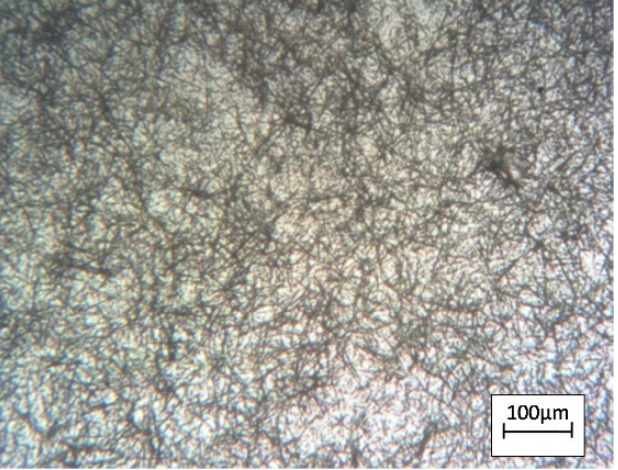
Figure 5. Silver nanowires obtained by adding K 4 Fe(CN) 6 in the field of an optical microscope. The structural characteristics of the silver nanowires synthesized by both conven- tional and microwave methods were studied by scanning electron microscopy (SEM). Figure 6 shows the SEM images of Ag_NW nanowires obtained by the conventional method (Figure 6a) and those obtained by microwave radiation (Figure 6b). According to the atomic-force microscopy data (Figure 7), a silver nanowire has a uniform distribution by thickness of about 200 nm and by length of about 7 µ